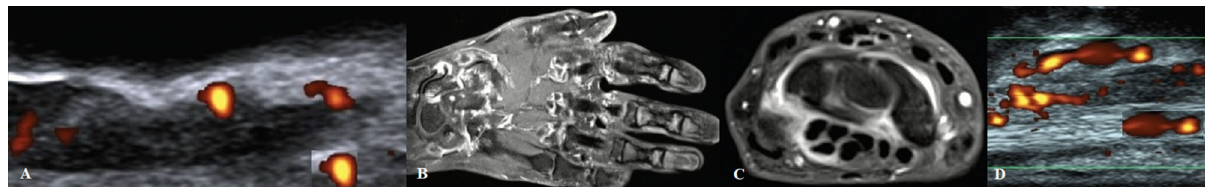
Figure 2 - A. Ultrasound image (longitudinal view) of a female patient (age 48 years) with inflammatory joint pain showing synovitis in the first proximal interphalangeal joint. B. Contrast-enhanced magnetic resonance image of the hand of a male patient (age 49 years) with inflammatory joint pain showing inflammatory cysts, erosion, and synovitis in radiocarpal, carpometacarpal, midcarpal, and metacarpophalangeal joints. C. T1-weighted contrast-enhanced magnetic resonance image of the carpalia of a female patient (age 51 years) with inflammatory joint pain showing synovitis in the joints. D. Ultrasound image (longitudinal view) of the extensor carpi ulnaris tendon of a female patient (age 47 years) with inflammatory joint pain showing tenosynovitis.